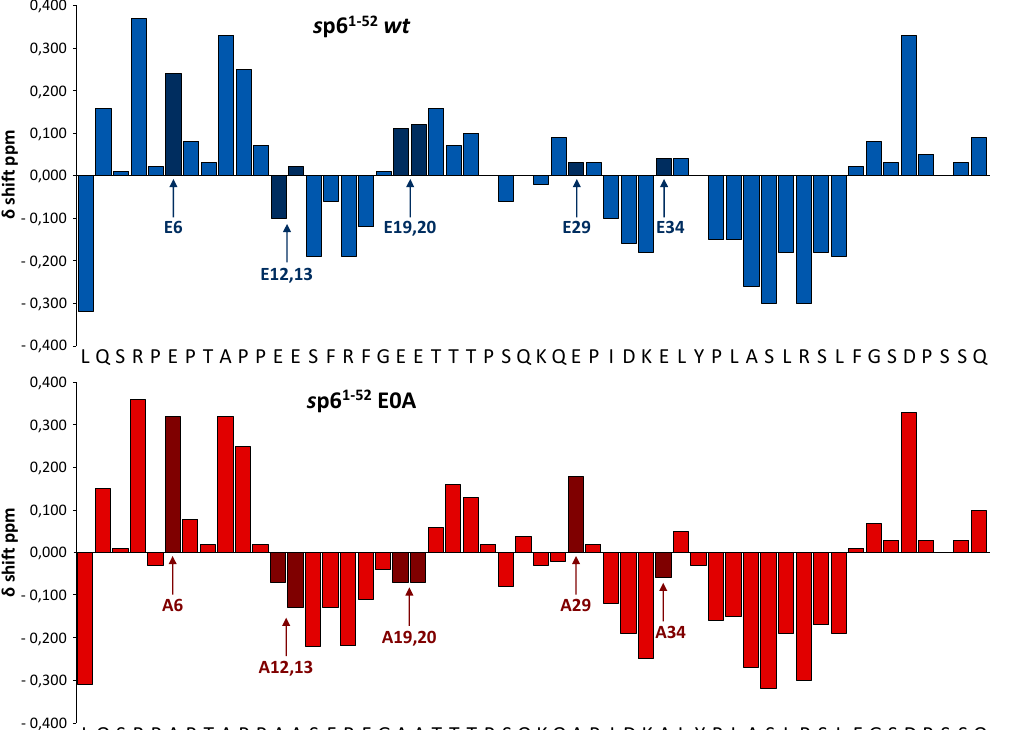
Figure 8. Mutation of Glu residues to Ala extends the N-terminal α -helix of p6. Chemical shift differences (ppm) of the α -protons between the experimental values and those for residues in a random coil for p6 wt [50] compared with the E0A mutant in 50% aqueous TFE-D 2 at pH 3 at 300 K. All positive values for N-terminal residues adjacent to proline residues arise from an inherent effect of proline and not out of a structural perturbation, as described in ref. [62].